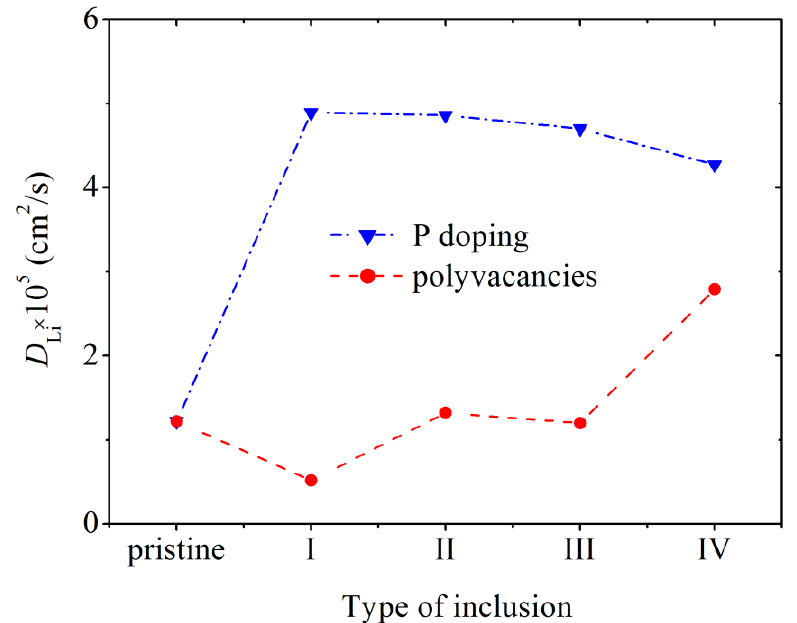
Figure 14. Diffusion coefficient of Li ions during their movement along a pristine silicene channel and a channel whose walls contain P atoms and polyvacancies: I, II, III, IV — mono-, bi-, tri-, and hexavacancies in silicene, respectively; in all cases, the silicene channel is located on a graphite substrate with a nitrogen content of 5%. Adopted with permission from Ref. [11]. 2021, Elsevier.